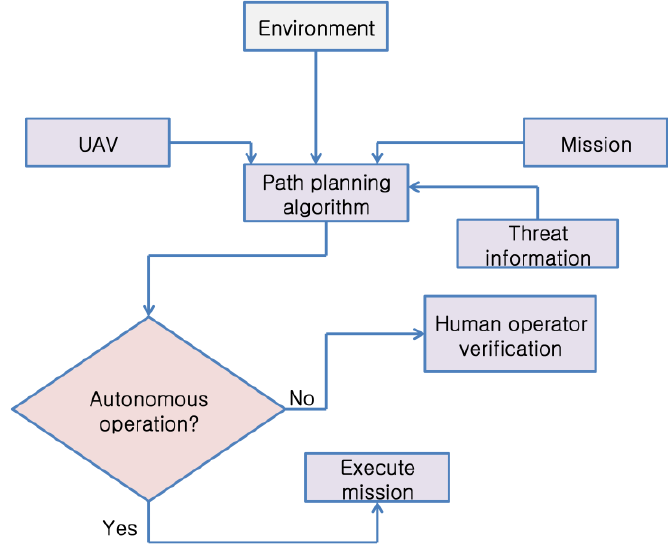
Figure 1. Constraints on path planning in UAVs.